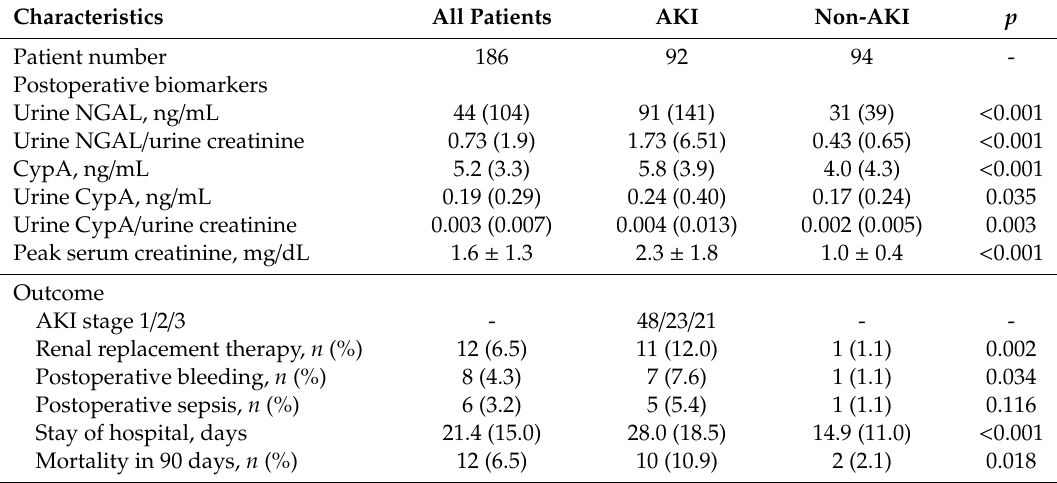
Table 2. Postoperative biomarkers and outcomes of the patients with and without AKI after cardiac